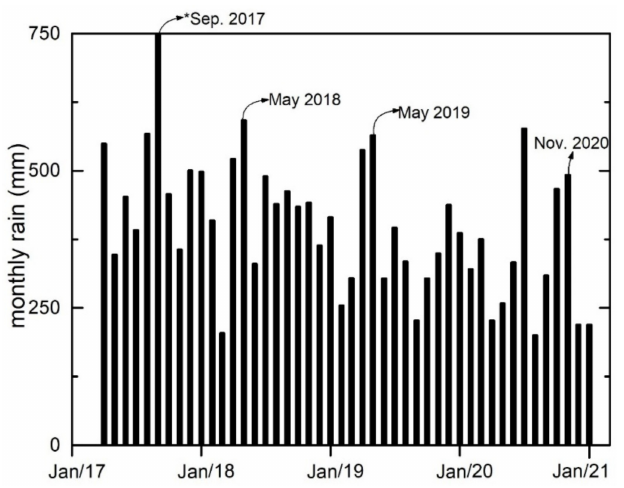
Figure 5. Monthly rain (in mm) measured by the Sanner weather station (operated by the OVSG-IPGP; 16.04497 ◦ N, 61.66272 ◦ W, 1076 m), which was located on the volcano summit. The data were extracted from monthly bulletins of the OVSG-IPGP [56]. * Monthly rainfall from September 2017 (>2000 mm) was overestimated because of technical issues in the weather station caused by Hurricane